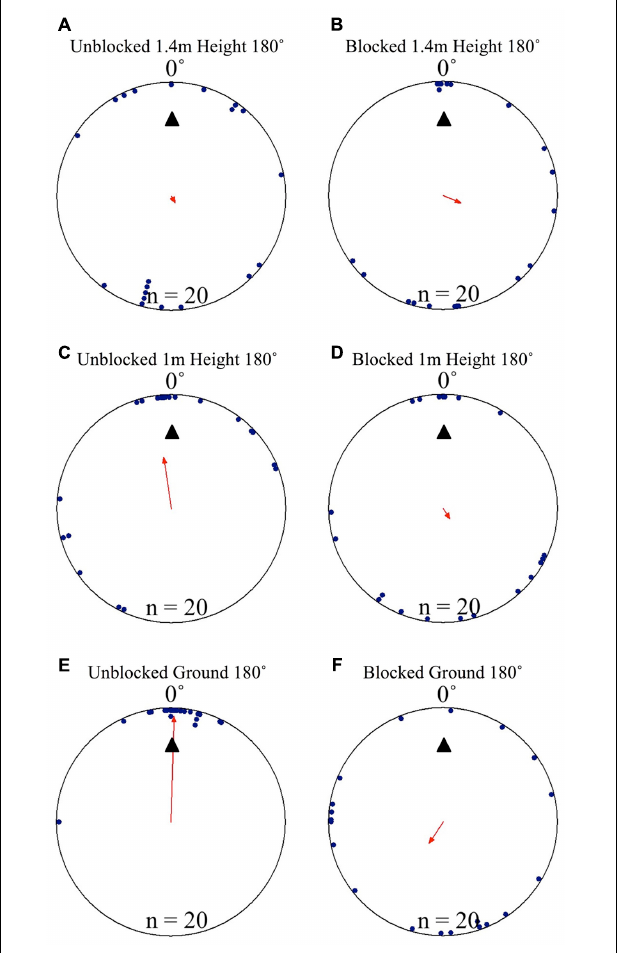
positions on the tree face during the landmark blocking experiments on the nest tree. Figures show the raw data of forager positions at three heights after displacements to one of two sides of the tree at a 1.5 m height at Nest 3. The nest direction for each figure is at 0 ◦ . The arrow denotes the direction and length of the mean vector. Foragers were collected at the base of the nest tree, held overnight and then released vertically on the tree face of the nest tree opposite the nest entrance (180 ◦ ) with the surrounding landmark panorama either unblocked or blocked. (A) The position on the tree face of individual foragers released at the 180 ◦ location as they begin their descent at 1.4 m in height with the surrounding landmarks unblocked. (B) The position on the tree face of individual foragers released at the 180 ◦ location as they begin their descent at 1.4 m in height with the surrounding landmarks blocked. (C) The position on the tree face of individual foragers released at the 180 ◦ location at 1 m in height with the surrounding landmarks unblocked. (D) The position on the tree face of individual foragers released at the 180 ◦ location at 1 m in height with the surrounding landmarks blocked. (E) The position on the tree face of individual foragers released at the 180 ◦ location as the forager reaches the ground with the surrounding landmarks unblocked. (F) The position on the tree face of individual foragers released at the 180 ◦ location as the forager reaches the ground with the surrounding landmarks